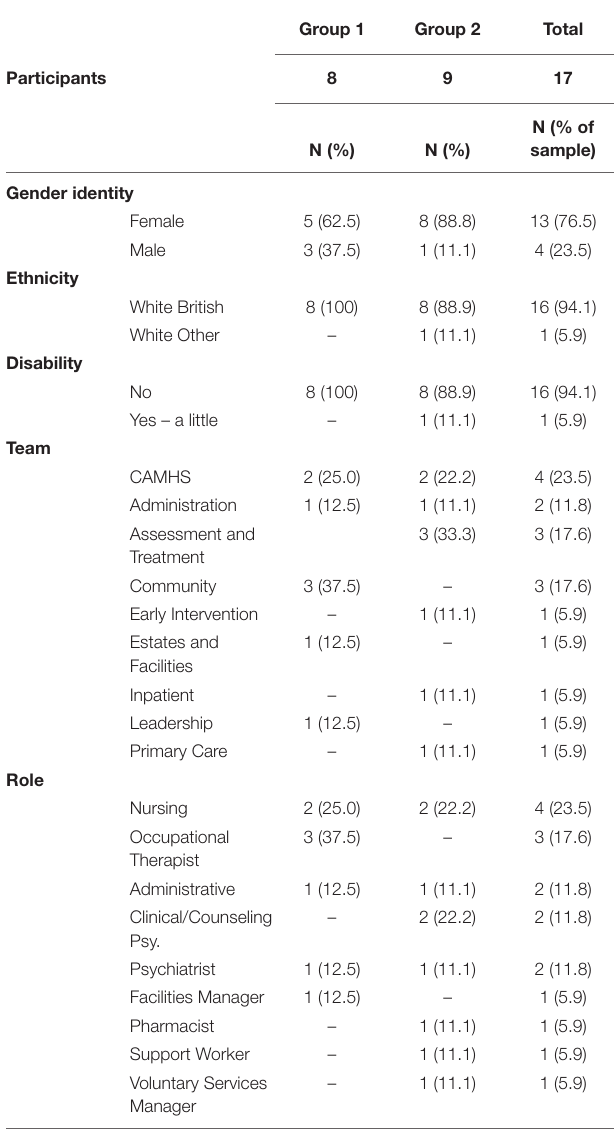
TABLE 1 | Participant demographic data displayed by